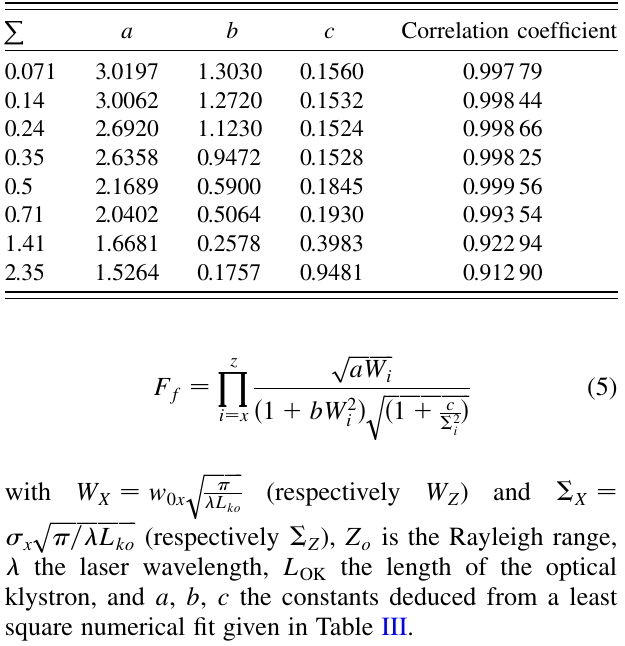
TABLE III. Values of the empirical parameters of the Filling factor expression.